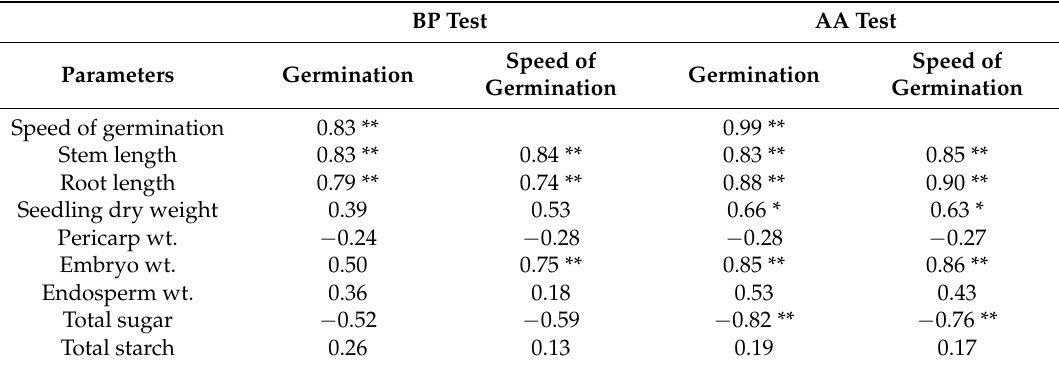
Table 3. Correlation among germination parameters with total sugars and starch contents under BP test and AA test ( n = seven inbred lines and four